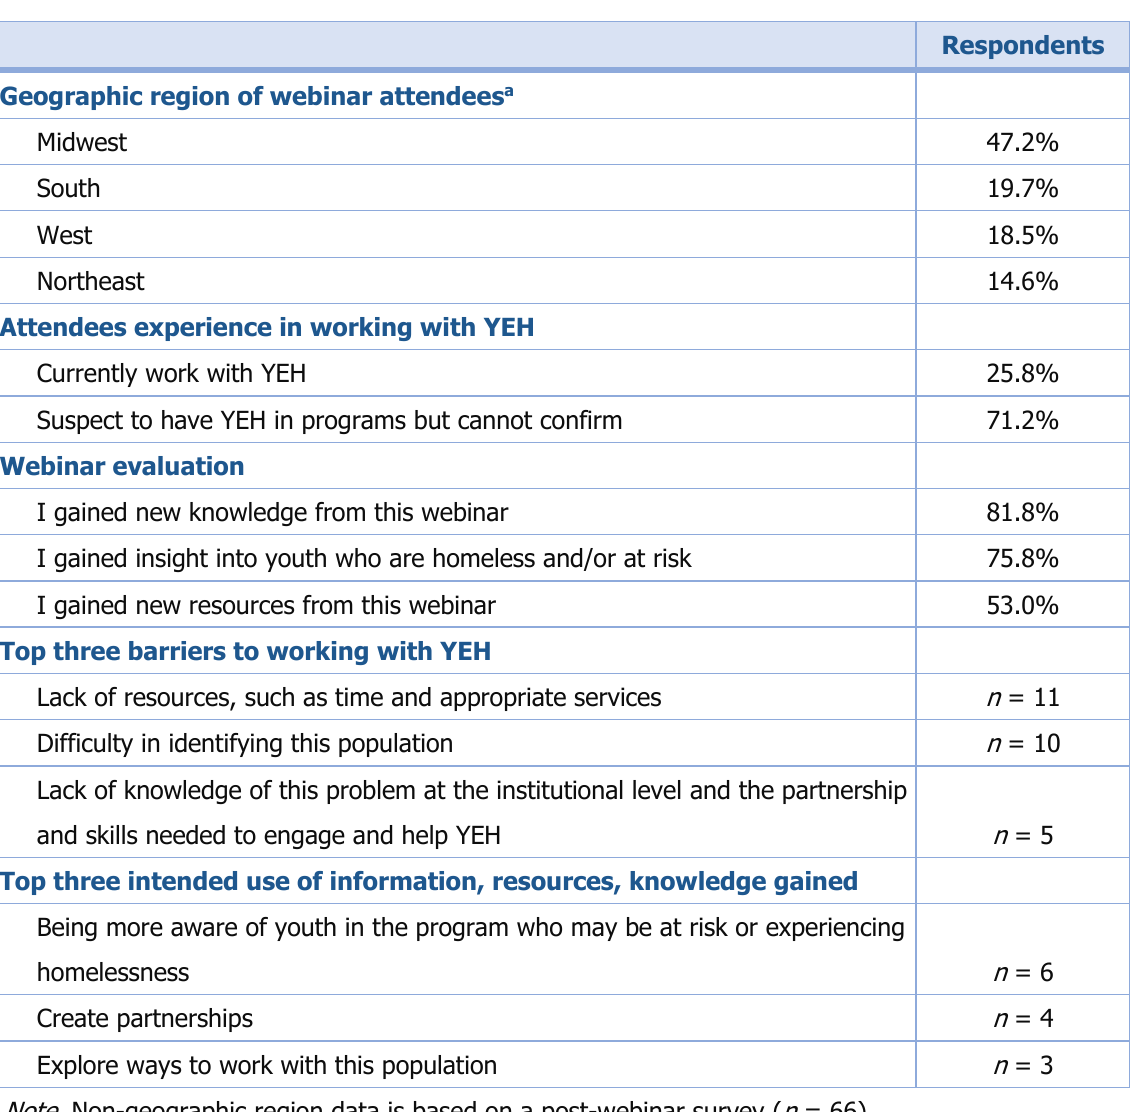
Table 1. Webinar for Extension Professionals About Homeless Youth and Youth At- Risk for Homelessness